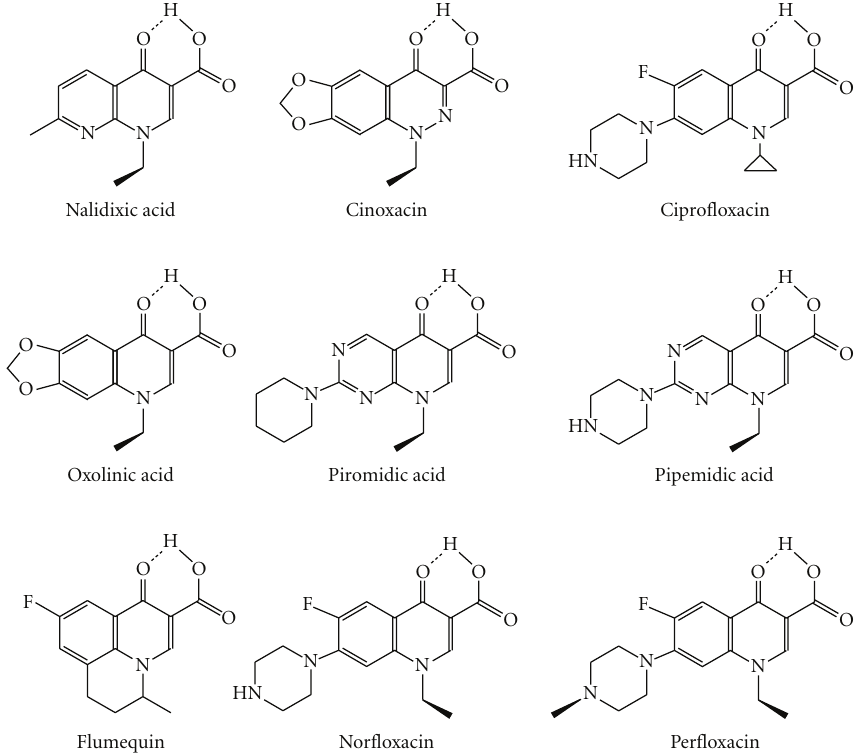
Figure 1: Some quinolone and fluoroquinolone drugs chemical